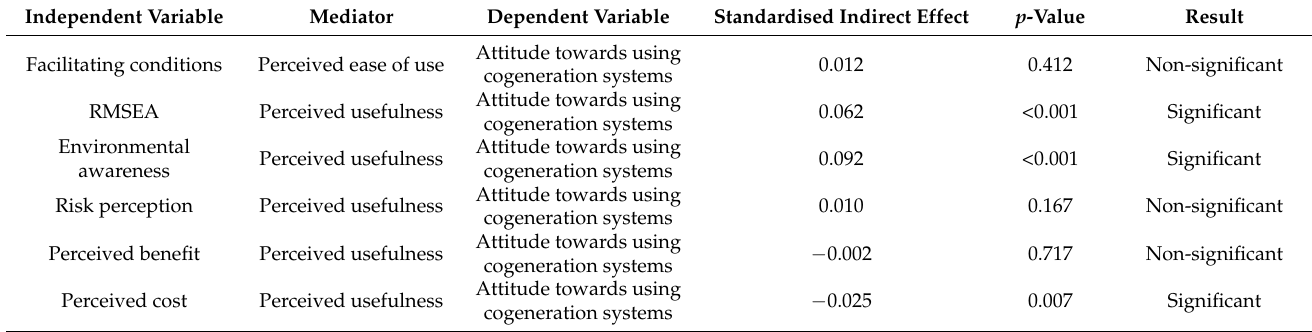
Table 8. Results of mediation